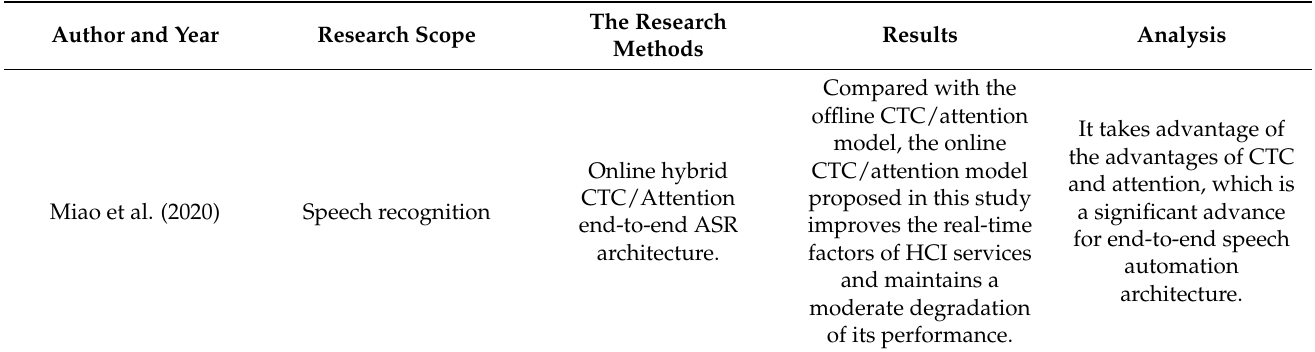
Table 1. Development status of deep learning technology in assisting voice interaction in intelli- gence